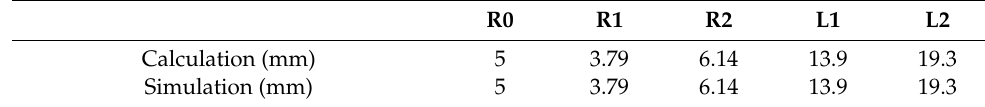
Table 1. The structure size of TE 02 -TE 01 mode converter.